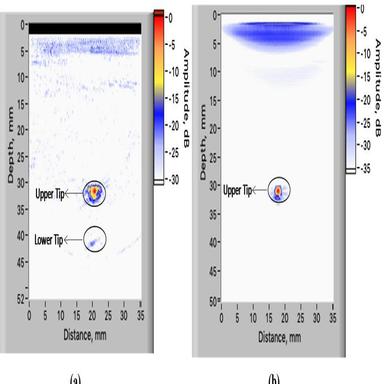
Processed B-scan images for 0 inclined slot in 60 mm thick stainless steel plate (a) PA-SAFT and (b) FMC + TFM.